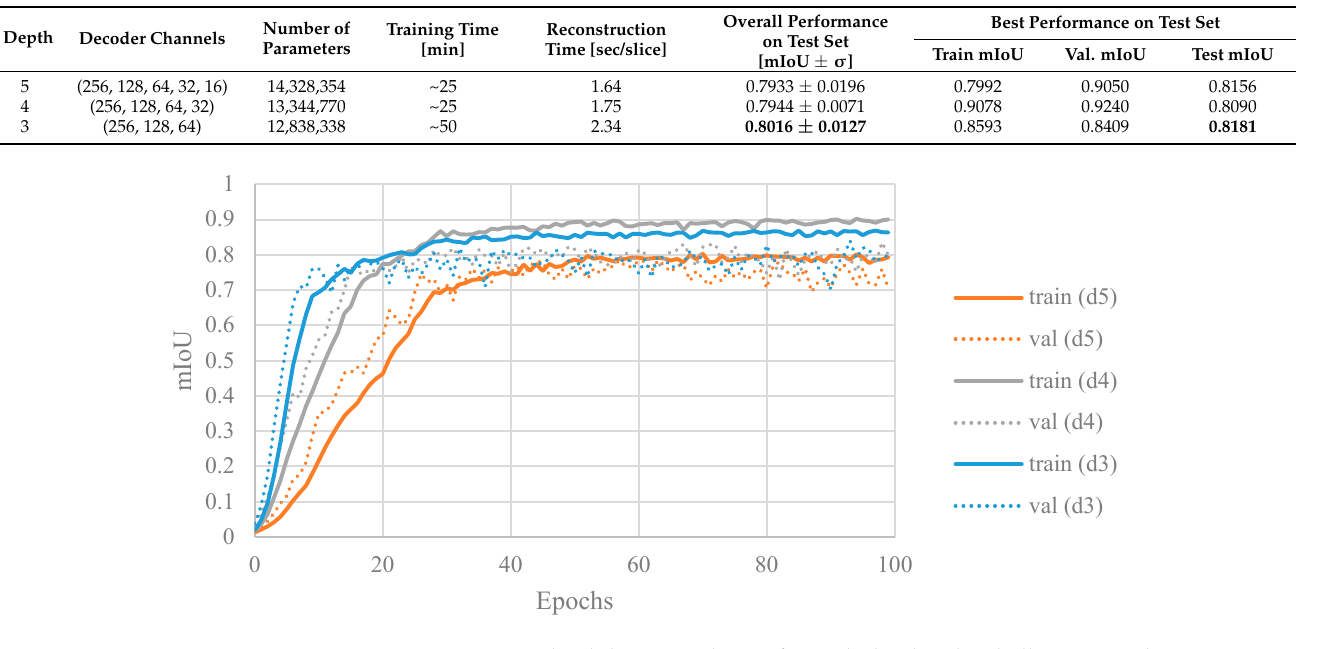
Figure 11. Box and whisker plot of mIoU on test set for different depth of U-Net.